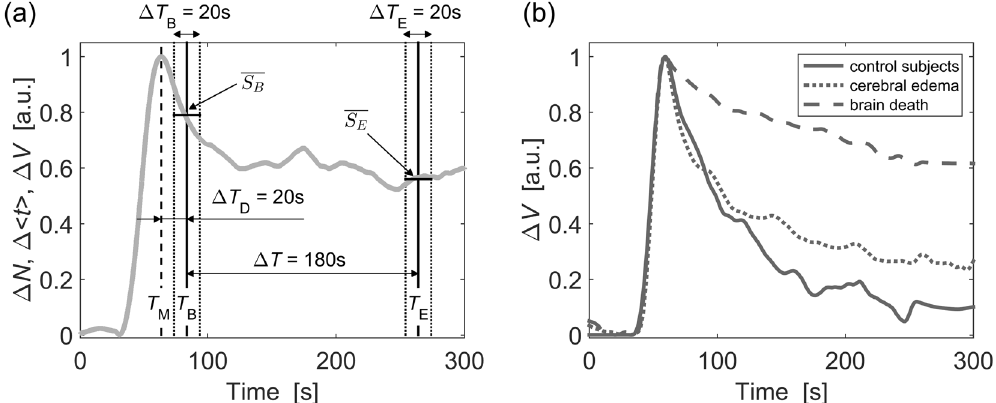
Figure 4. ( a ) Algorithm for the data analysis used in the assessment of the ICG washout ratio. T M - time of maximum amplitude of the signal, T B – time at which the baseline signal level was obtained (20 seconds after T M ). Averaged signal amplitude S was calculated within the Δ T B period. T E – time at which the late signal level B was obtained (180 seconds after T B ). S - averaged signal amplitude within the Δ T E period. ( b ) Examples of E normalized time courses of variance of the statistical moments of the distributions of times of arrival (DTAs) of fluorescence photons ( Δ VF) acquired during injection of ICG in a control subject, patient with brain edema and patient with brain death. R VF variables calculated from these signals ( Δ VF) were most significant in study groups differentiation (please, see Results section). For presentation purposes signals obtained in different subjects/patients were aligned by their maximum